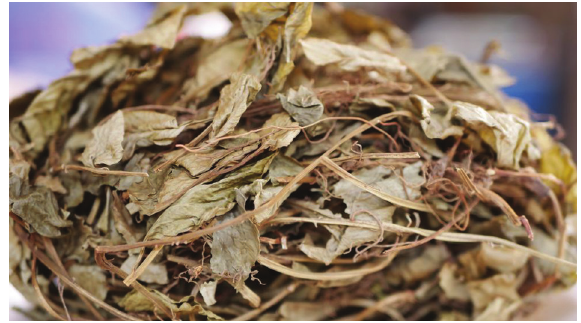
Figure 1: Dried Lysimachia foenum graecum leaf.